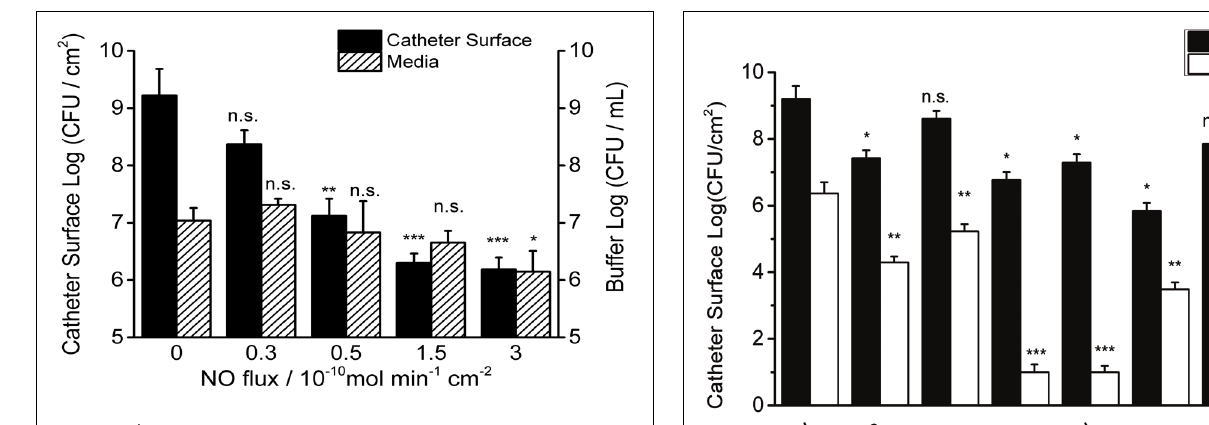
FIGURE 3 | Dosage effects of 3 h NO release on 7-day P. aeruginosa biofilms. Viable bacteria were measured both on the surface of catheters and in the buffer after NO turned “on” for 3 h at room temperature. Asterisk denotes statistical significance at each flux compared with corresponding 0 flux ( n = 3 catheters for each flux, n.s.: no significance, ∗ p < 0.05; ∗∗ p < 0.01, ∗∗∗ p < 0.001). TABLE 1 | Effect of NO flux on dispersing and killing of 7-day Pseudomonas aeruginosa biofilm. †